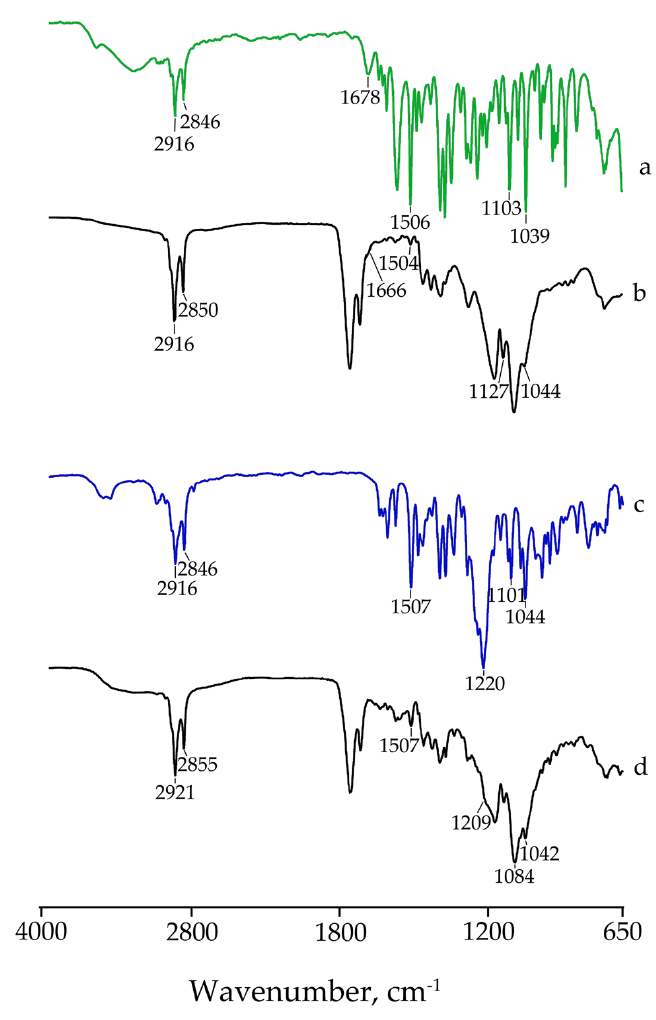
Figure 6. FT-IR spectra of BBR-L salt ( a ), NPs BBR-L ( b ), BBR-S salt ( c ), and NPs BBR-S ( d ).